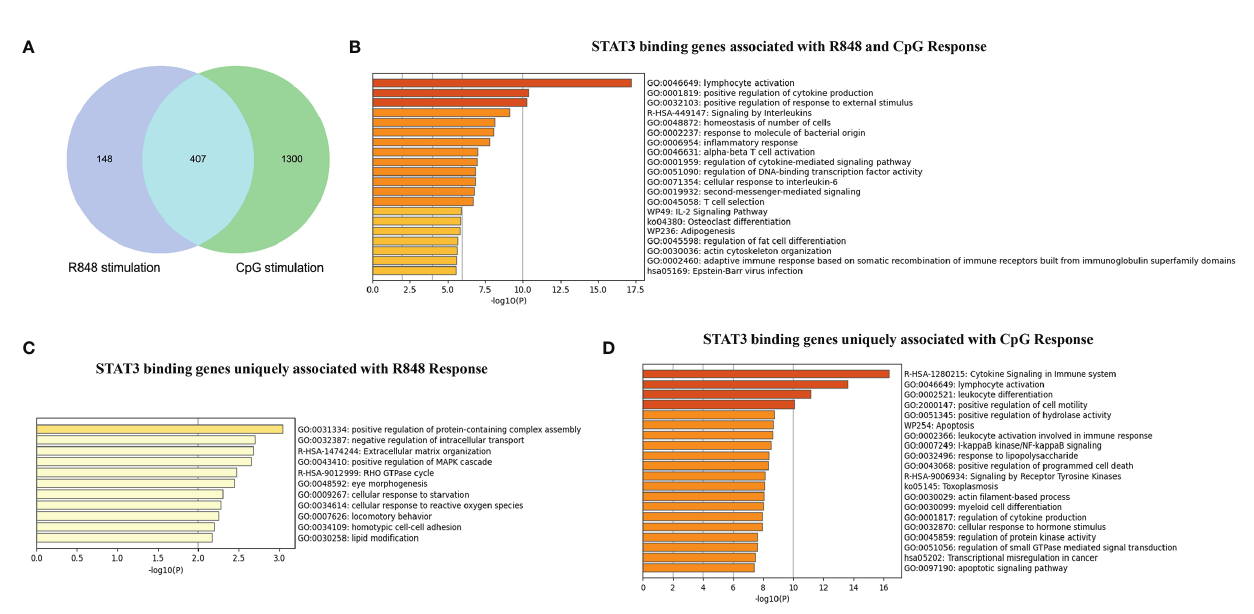
FIGURE 2 | Comparison of STAT3 binding genes induced by TLR7 and TLR9 agonists stimulation in human B cells. (A) Venn diagram showing the overlap of STAT3 binding genes induced by R848 and CpG stimulation. Metascape software was use to perform functional annotation of overlapped STAT3- binding genes induced by R848 and CpG stimulation (B) , STAT3-binding genes uniquely induced by R848 stimulation (C) , and STAT3-binding genes uniquely induced by CpG stimulation (D)